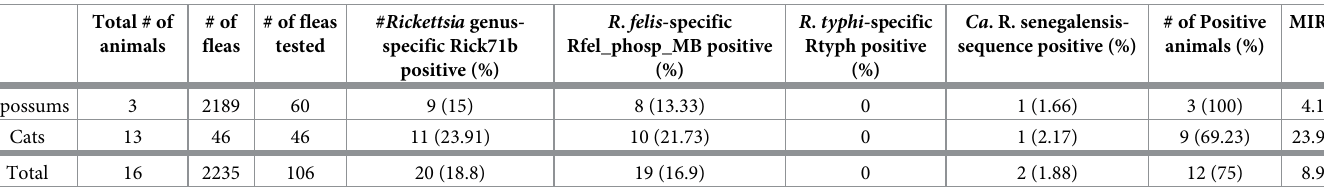
Table 3. Summary of qPCR assay results for individual fleas from 3 opossums and 13 cats at the mobile home community in Los Angeles County, California. Total # of animals